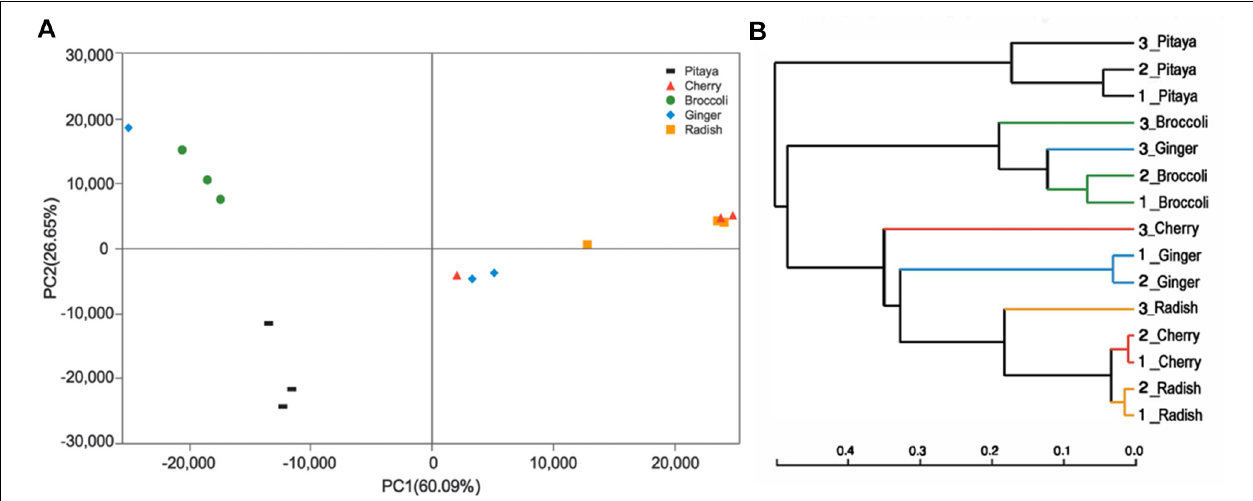
FIGURE 2 | Variance analysis of the bacterial communities among the fermented juices. (A) PCA plots indicate the abundance of diverse bacteria in the fermented juices. The first principal component (PC1) and second principal component (PC2) shows 26.65 and 60.09%, respectively, of the variance in the unweighted Unifrac metrics. Each point represents the microbiota from a single sample. (B) Hierarchical clustering of the group means based on UPGMA.